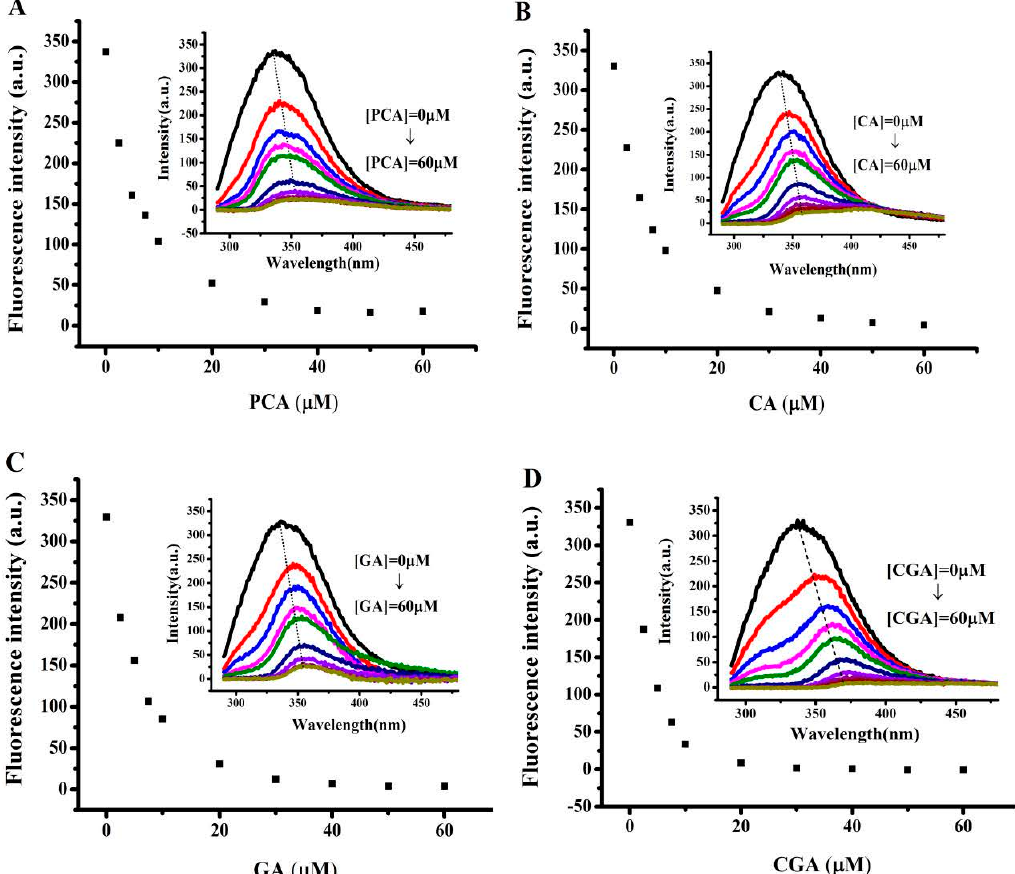
Figure 4. Fluorescence spectra of soy protein 7S and soy protein 7S treated with: ( A ) PCA; ( B ) CA; ( C ) GA; and ( D ) CGA at different concentrations. Conditions: 1 μ M 7S in 100 mM MOPS (5 mM NaCl), [phenolic acids] = 60 µ M, pH 7.0, 25 ◦ C. λ E x = 280 nm, slits for excitation and emission are 5 nm and 10 nm, respectively.